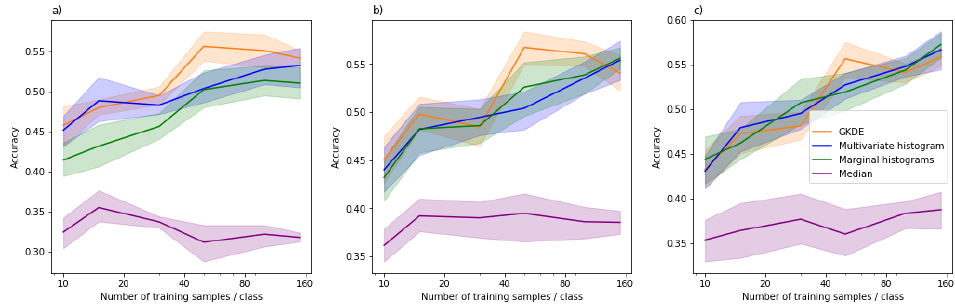
Figure 5. Density estimates, histograms and the median as representations for multispectral NDVI/NDTI data across three different classifiers. ( a ) SVC ( b ) MLP ( c ) RF. Each color corresponds to a representation, the line indicates the average over five random training sets evaluated on a single test set, and the shaded areas represent 95% bootstrapping-based confidence